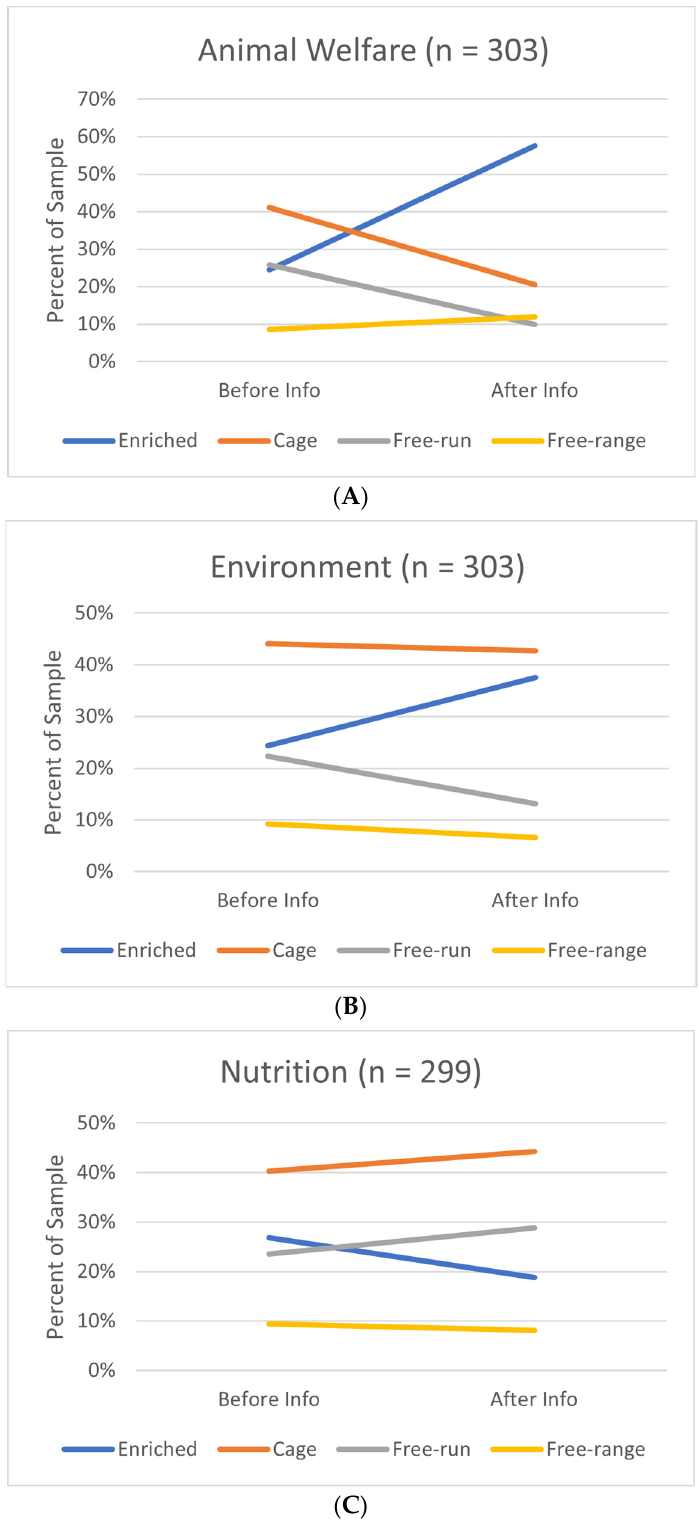
Figure 3. ( A ) Choice shares of each type of fresh egg before and after information—treatment animal welfare; ( B ) choice shares of each type of fresh egg before and after information—treatment environment; ( C ) choice shares of each type of fresh egg before and after information—treatment nutrition.